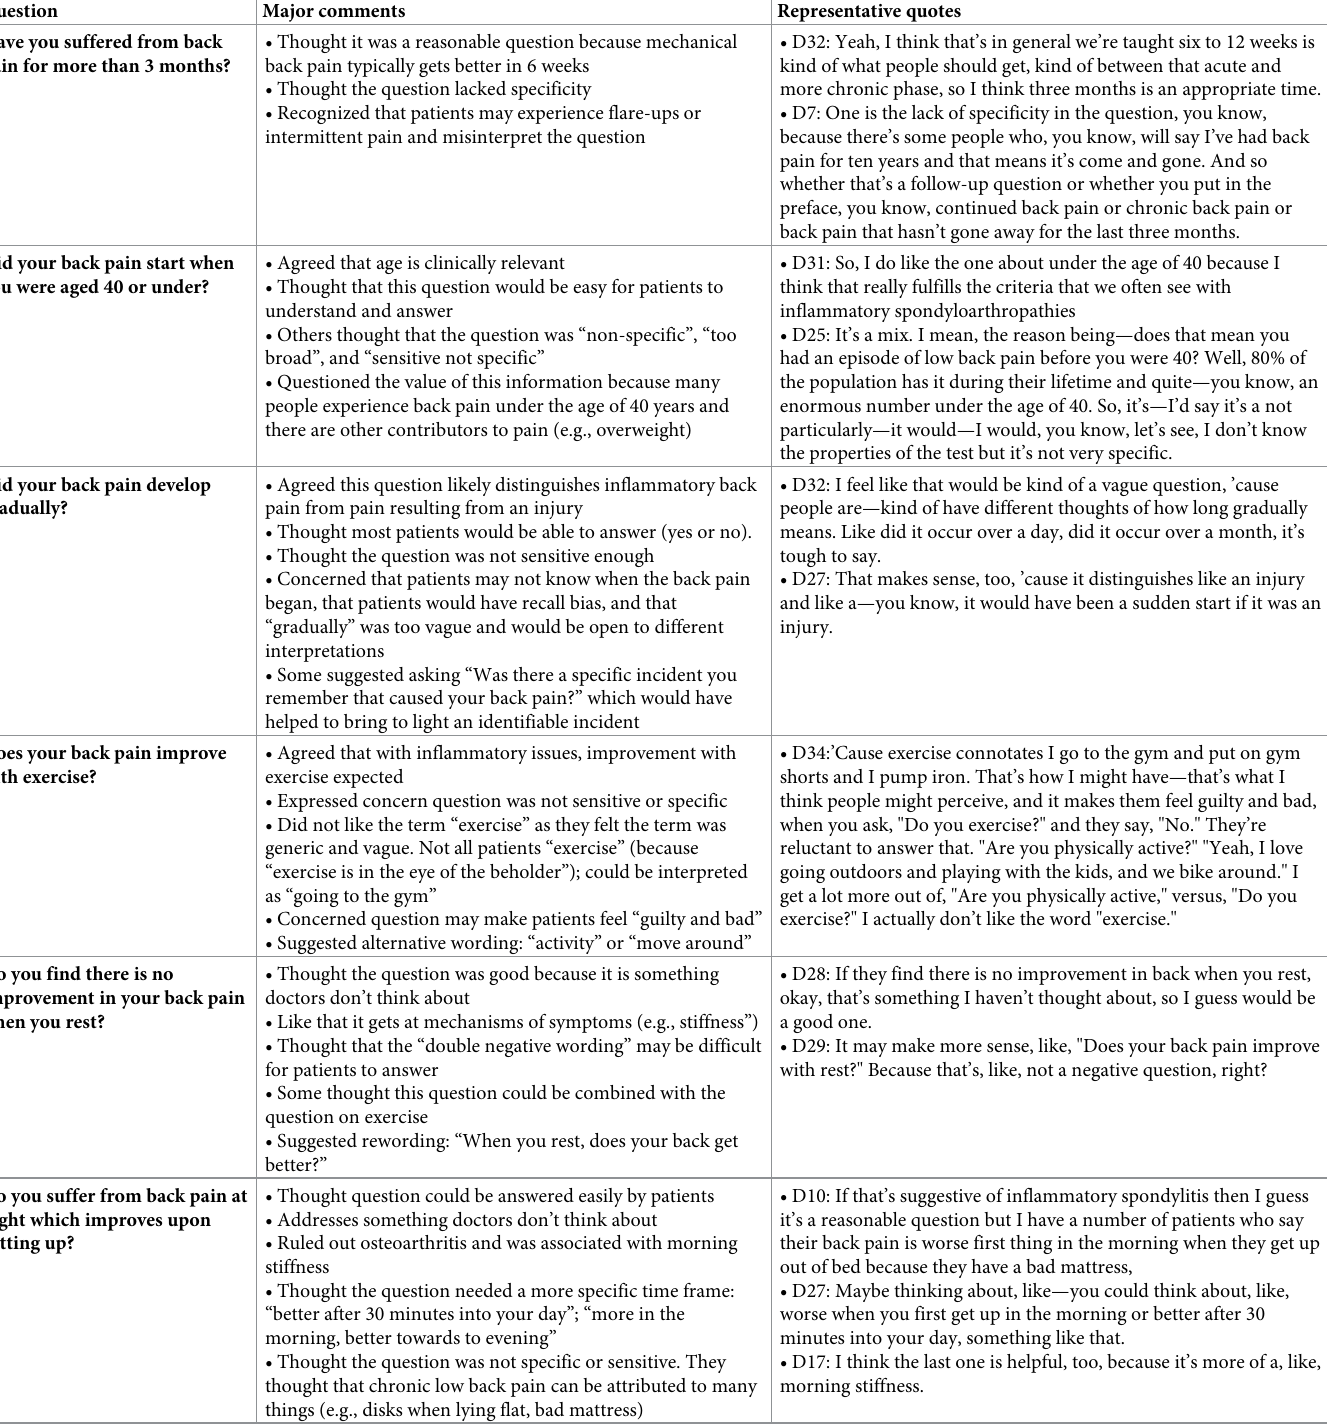
Table 4. Synthesis of feedback from primary care physicians on Assessment of Spondyloarthritis International Society screening